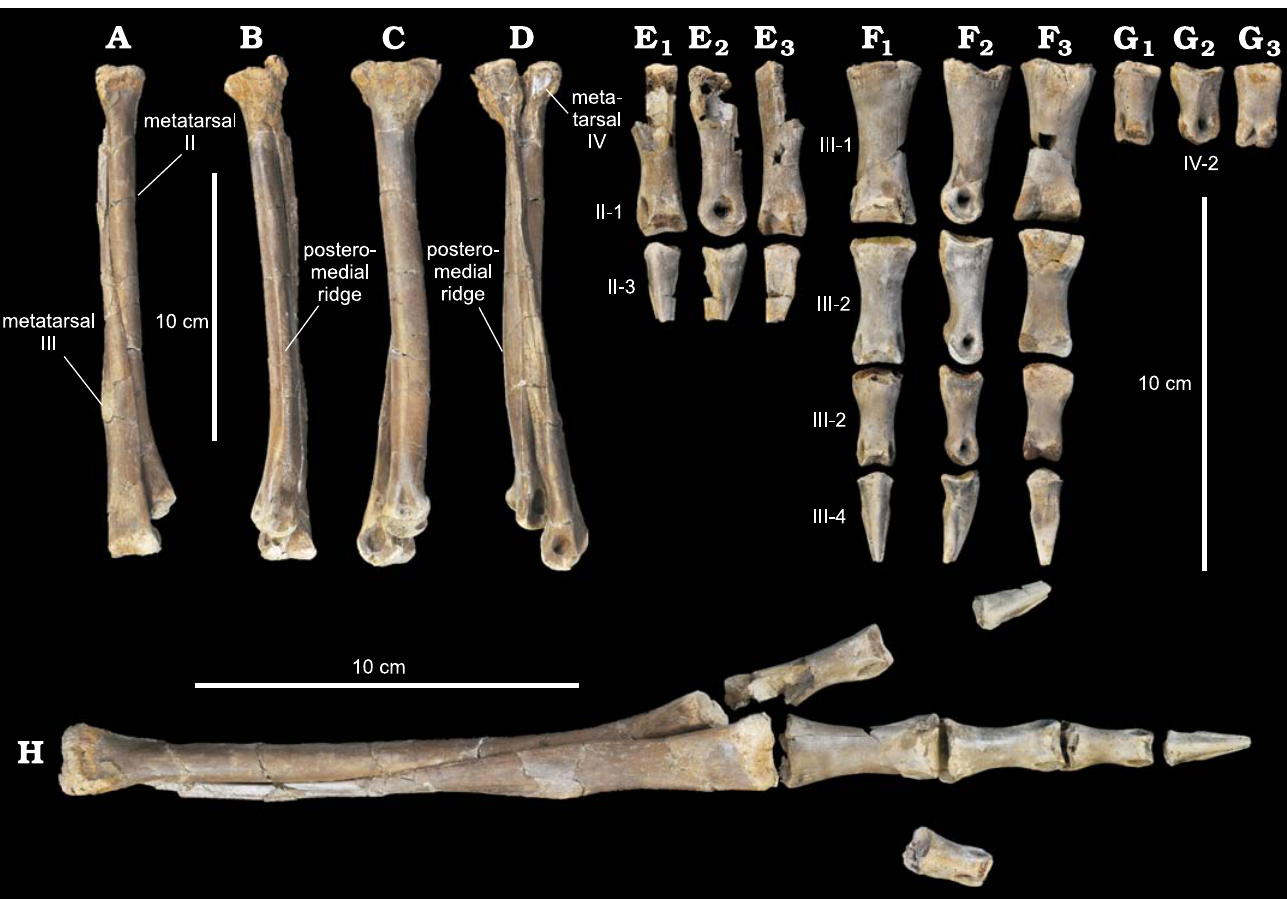
Fig. 7. Elmisaurine dinosaur Leptorhynchos elegans (Parks, 1933) (TMP 2000.012.0008) from Upper Campanian Dinosaur Park Formation, Dinosaur Provincial Park, Alberta, Canada. Partial foot, articulated metatarsals II and III in anterior ( A ), posterior ( B ), medial ( C ), and lateral ( D ) views. Pedal phalanges of digits II ( E ), III ( F ), and IV ( G ) in dorsal (E 1 –G 1 ), lateral (E 2 –G 2 ), and ventral (E 3 –G 3 ) views. Reconstruction of foot in anterior view ( H